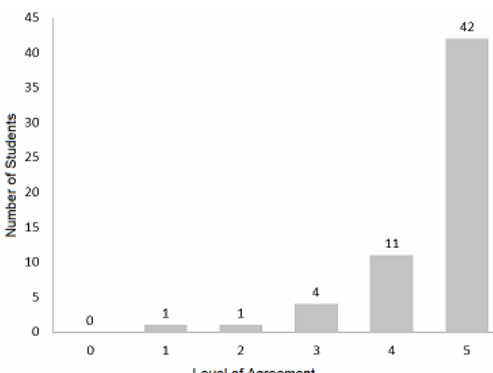
Figure 7. "You have learned in this program better than you would have in a Face-to-Face